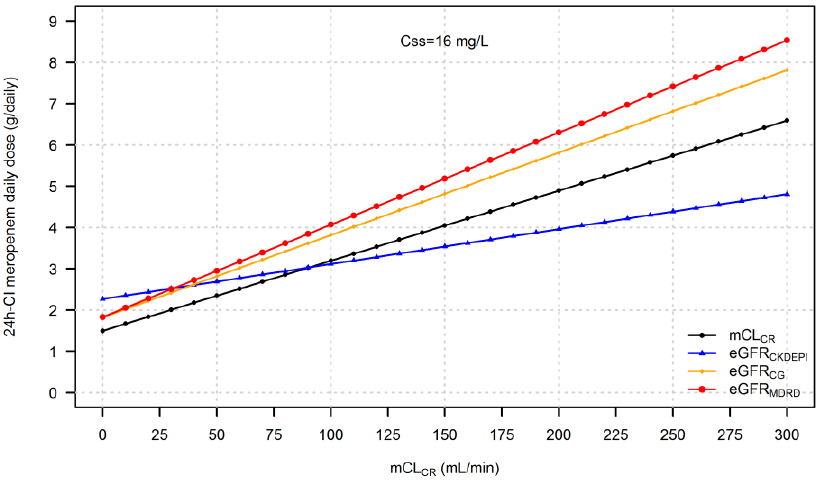
Figure 5. Twenty-four h-CI meropenem daily doses are necessary to achieve the targeted C ss of 16 mg/L by using eGFR CKDEPI , eGFR CG , or eGFR MDRD compared to mCL CR . Table 2. Differences in meropenem dose amount (in g/daily) when using eGFR formulas compared to mCL CR , for targeting Css at 8 and 16 Meropenem daily dosages based on eGFR equations were consistently different from those based on mCL CR . When GFR was calculated by means of eGFR CG or eGFR MDRD , higher than necessary doses were estimated due to an overestimation of mCL CR . Similarly, this occurs when using eGFR CKDEPI in patients with mCL CR < 90 mL/min. Table 2 reports